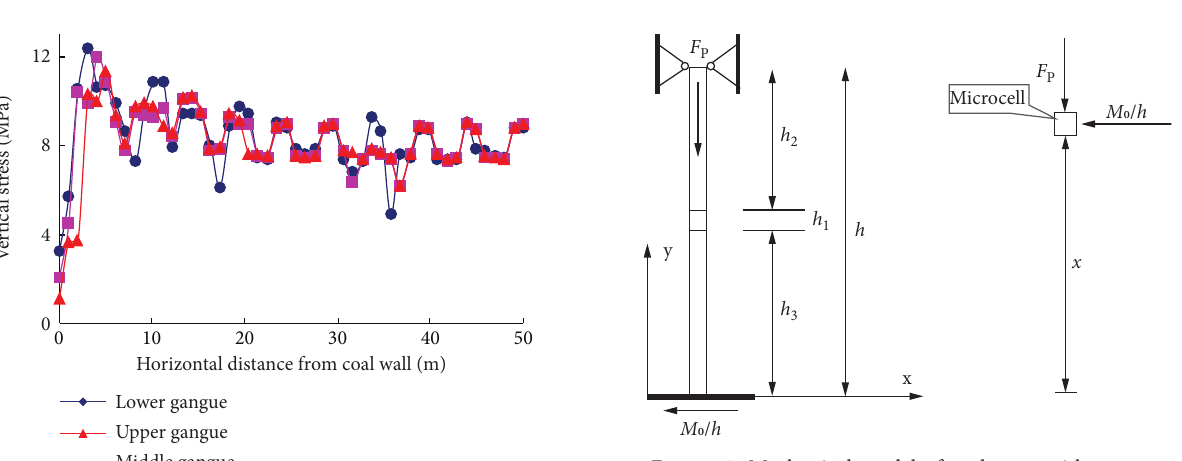
Figure 9: Mechanical model of coal seam with gangue.